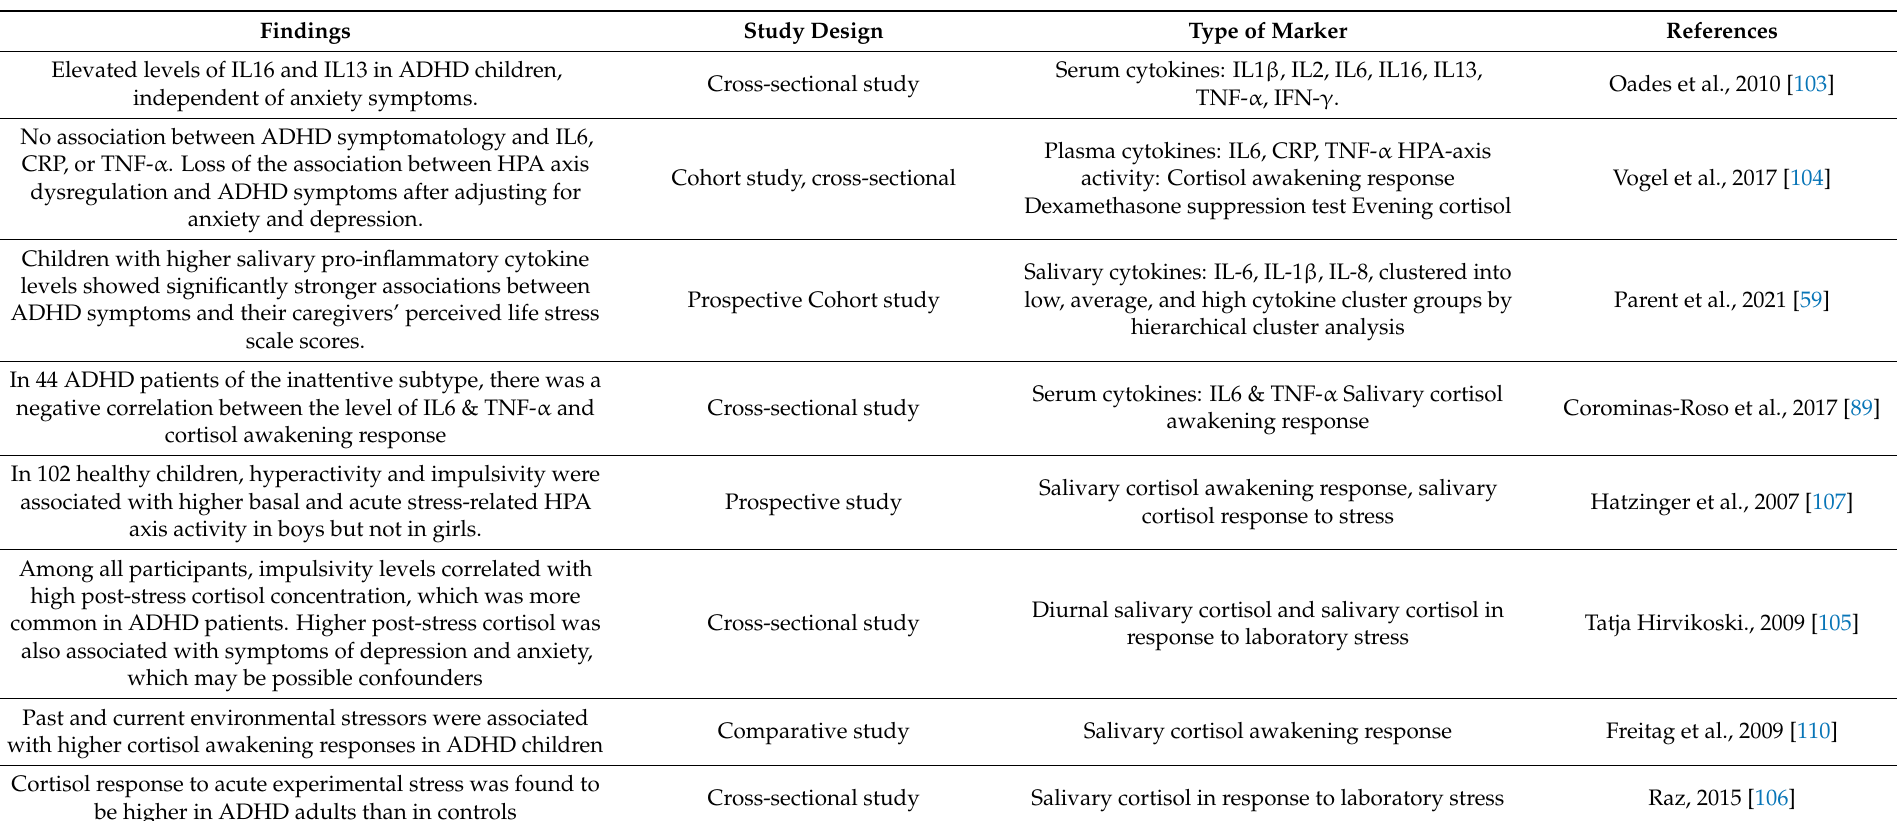
Table 2. Main studies linking either HPA-axis dysregulation or inflammation with attention-deficit/hyperactivity disorder